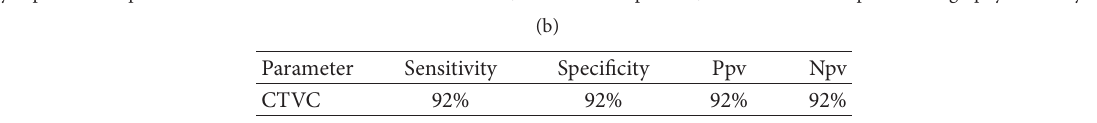
Other results were shown in Tables 1(b), 2(a)-2(b), and